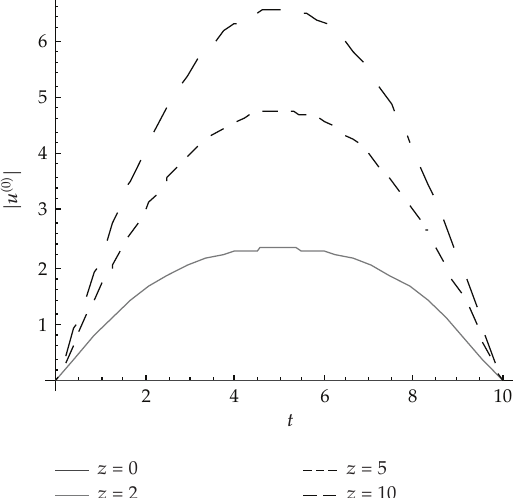
Figure 8: The zero-order approximation | u (cid:3) 0 (cid:4) | at α (cid:8) 1, T (cid:8) 10, γ (cid:8) 02 for di ff erent values of z , considering only one term in the series (cid:3) M (cid:8) 1 (cid:4)